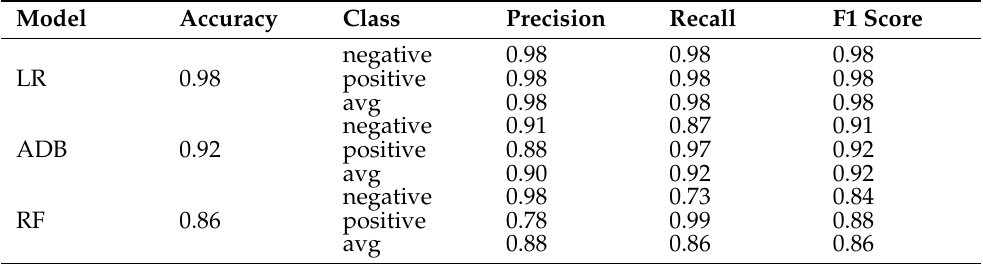
Table 13. Experimental results of ML models with TextBlob sentiments using the feature union. Model